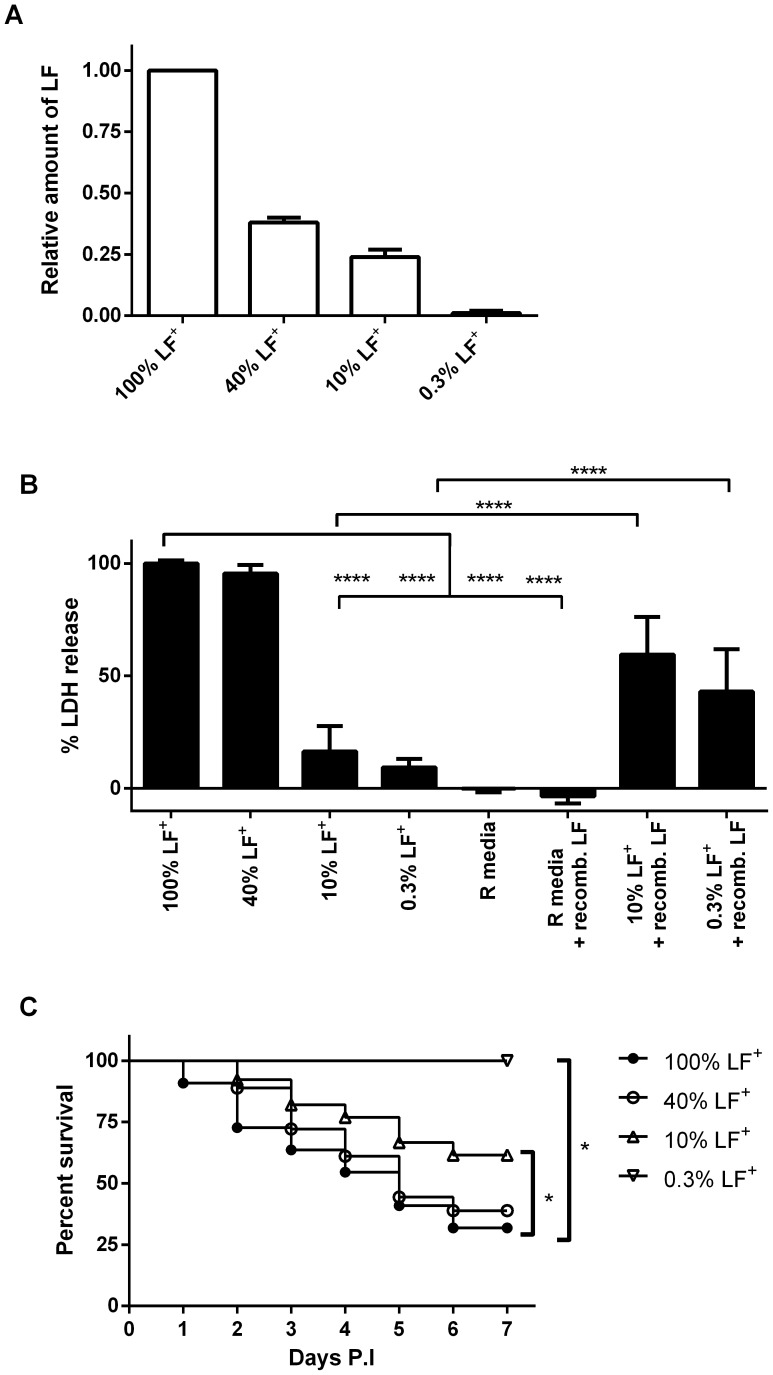
Decreasing LF producing clones in a signature tag library led to reductions in virulence.
A) Decreasing the amount of LF-producing clones in a library reduces the amount of LF that is produced when exotoxin is induced by R-media. All libraries were first normalized by the total protein in the lane. The amount of LF was determined relative to the 100% LF+ library. Western blotting was performed two independent times. Columns represent the median and bars represent the range. B) Decreasing the amount of LF-producing clones in a library led to reductions in macrophage cytotoxicity. RAW264.7 cells were plated in 96 well plates and treated with bacterial supernatants from exotoxin inducing R media. LDH release was measured and the %LDH release was calculated relative to the 100% LF+ supernatant. Experiments were repeated three independent times with at least 4 replicates per run. Asterisks represent a significant difference (One-way ANOVA with Tukey's multiple comparisons test. ****P-value <0.0001). Error bars represent the 95% confidence interval. C) Kaplan-Meier curve of mice infected with 2×105 CFU spores subcutaneously in the ear pinna. Mice were observed for 7 days. Solid circles represent mice infected with a library where all clones are LF+ (n = 22), open circles represent 40% LF+ library (n = 14), empty upward triangles represent 10% LF+ library (n = 39), empty downward triangles represent 0.3% LF+ clones library (n = 8). Asterisk represents a significant difference from the 100% LF+ library (Log rank test, *P-value <0.05).